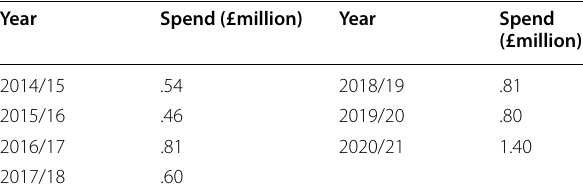
Table 1 Annual investment in bridge maintenance